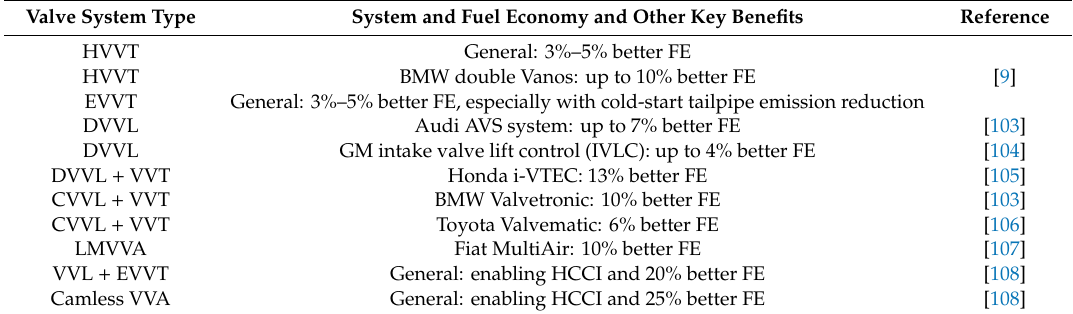
Table 3. Fuel economy